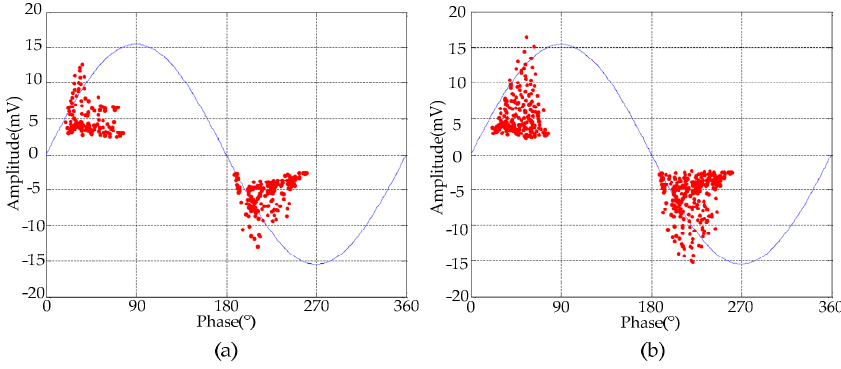
Figure 14. PRPD patterns corresponding to the detected UHF signals: ( a ) signal #1; ( b ) signal #2.